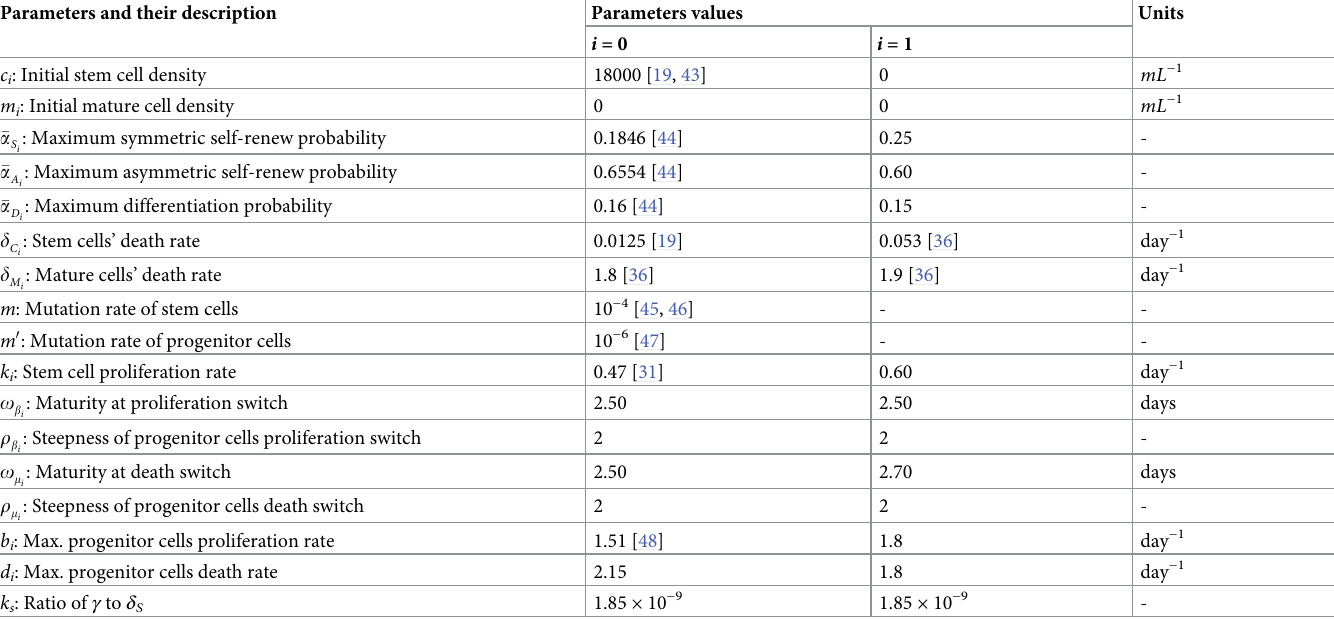
Table 1. Initial values and parameters of the model for both, healthy and mutated cell lineages, where i = 0 stands for the parameters of healthy cell line with zero mutation and i = 1 represents the parameters of mutated cell lineage with one mutation. Parameters and their